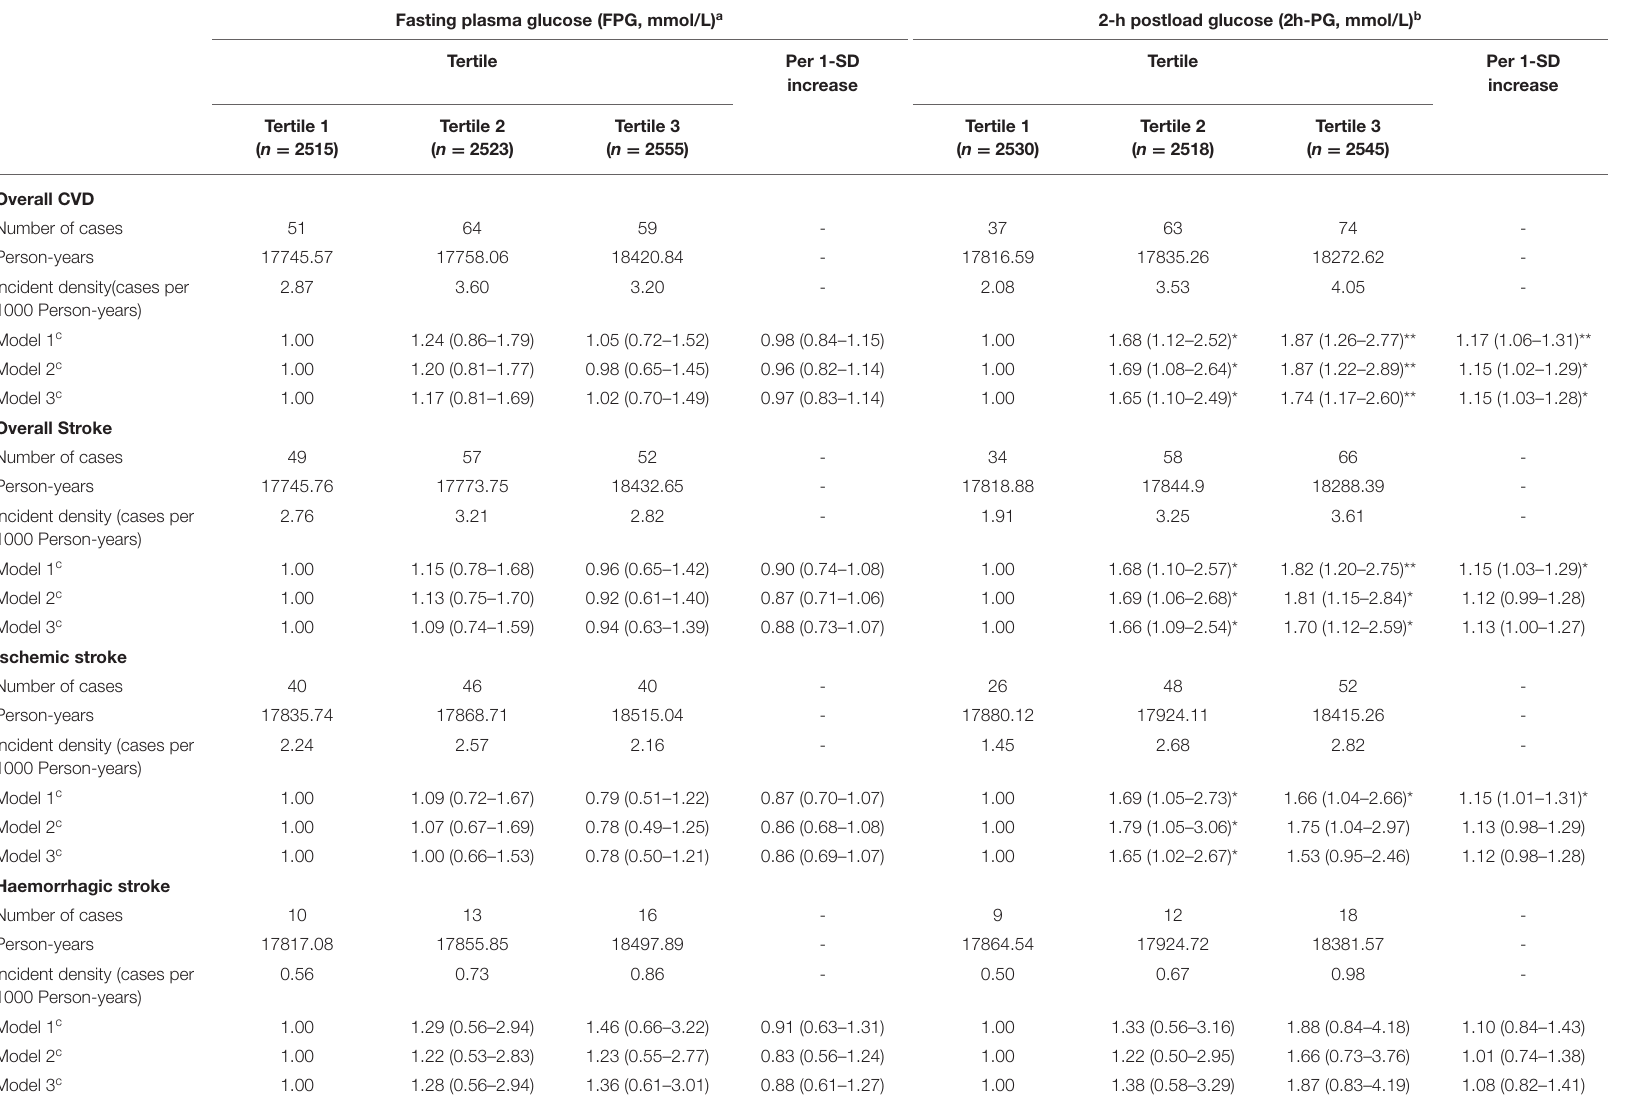
TABLE 2 | Hazard ratios (HRs) and 95% confidence intervals (95%CIs) for cardiovascular disease (CVD) associated with baseline fasting plasma glucose (FPG) and 2-h postload glucose (2h-PG) according to cox proportional hazards regression models. Fasting plasma glucose (FPG, mmol/L)